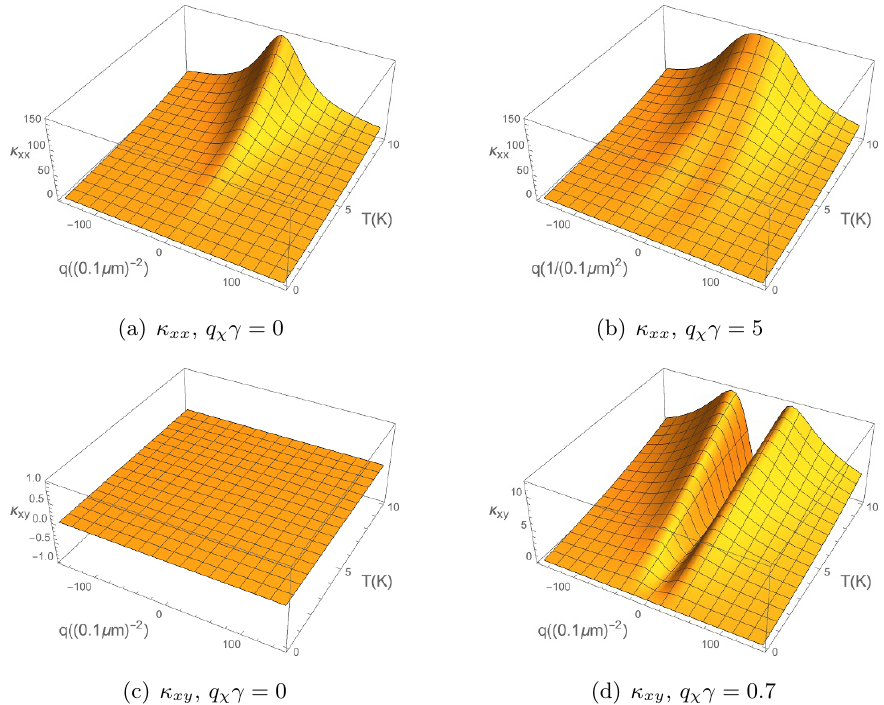
Figure 14 . The longitudinal thermal conductivity (cid:20) xx as a function of the charge and the temper- ature (a) without and (b) with magnetic impurity. (c) and (d) are Transverse thermal conductivity (cid:20) xy without and with magnetic impurity respectively.